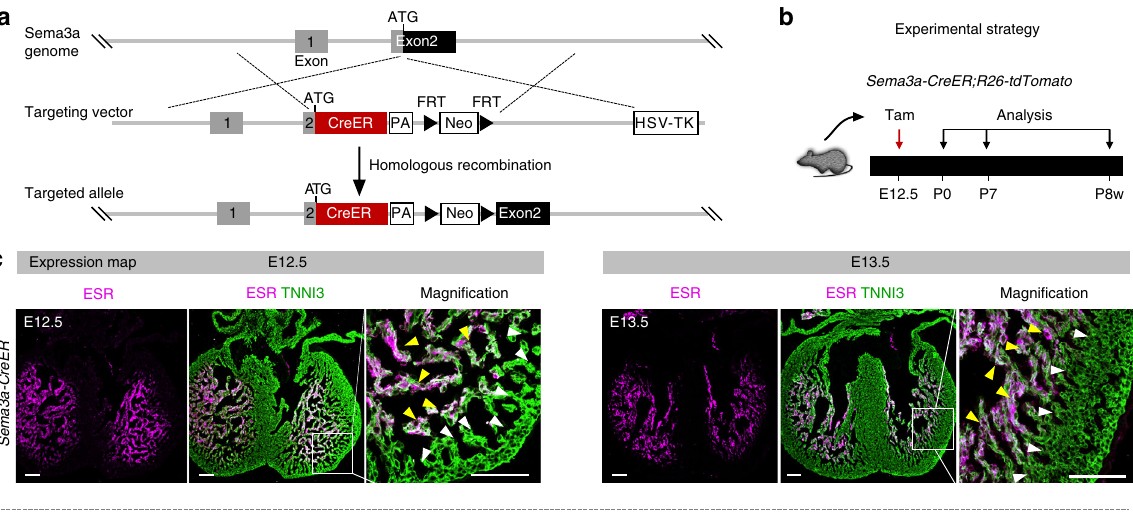
Inner layer of trabeculations Outer layer of trabeculations